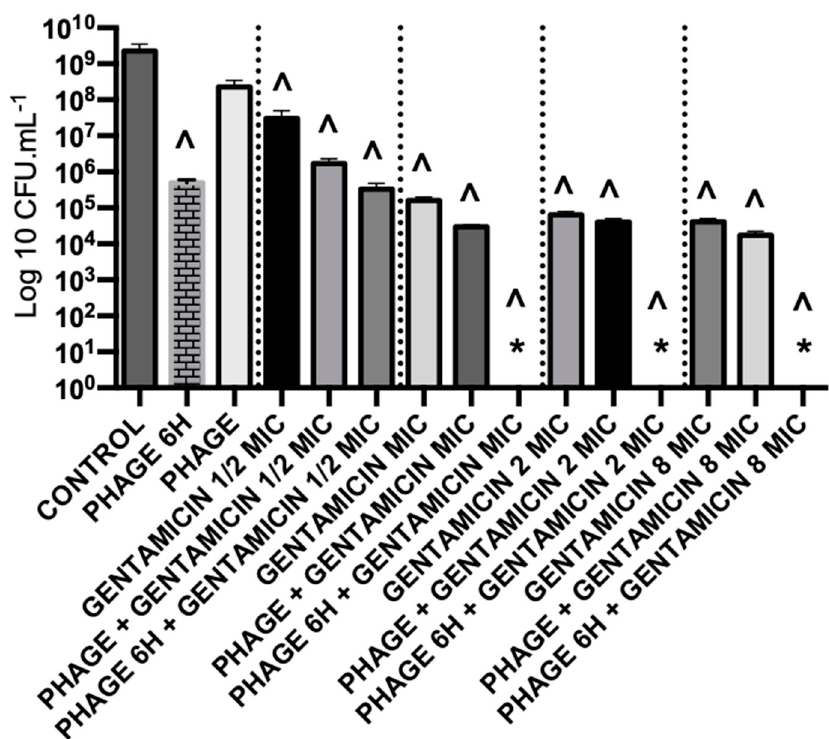
Figure 5. Treatment of P. aeruginosa PAO1 48 h biofilms with gentamicin at di ff erent concentrations. A prefix PHAGE indicates EPA1 in MOI 1, 1 / 2 MIC indicates the dose of antibiotics with 1 / 2 × MIC value, MIC indicates the dose of antibiotics with 1 × MIC value of P. aeruginosa , 2 MIC indicates the dose of antibiotics with 2 × MIC value of P. aeruginosa , 8 MIC indicates the dose of antibiotics with 8 × MIC value of P. aeruginosa , PHAGE + antibiotic indicates simultaneous treatment and PHAGE 6 H + antibiotics indicates phage was added first then antibiotic was added with 6 h delay. * Under detection limit ( < 10 2 ). ( ˆ ) Statistical di ff erences between the control and treated biofilms were determined by two-way repeated-measures analysis of variance (ANOVA) with a Tukey’s multiple comparison test.